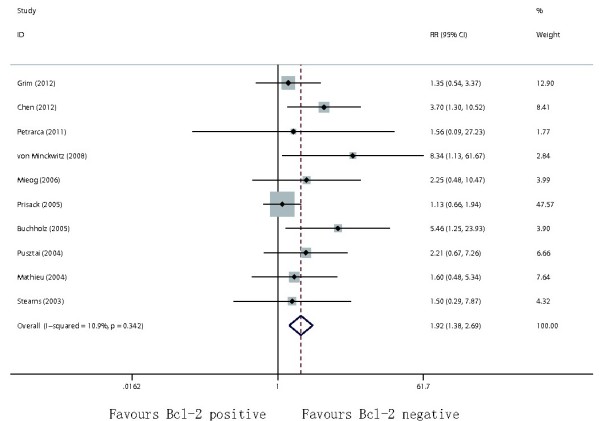
Forest plots of RR were assessed for association between Bcl-2 and pathological CR among breast cancer patients treated with neoadjuvant therapy.